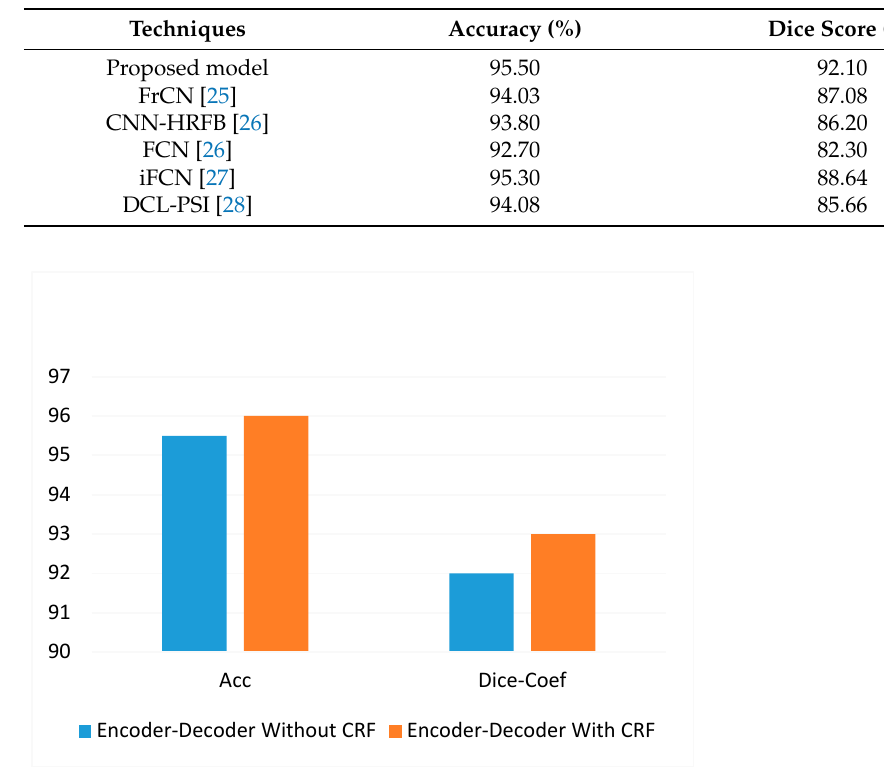
Table 3. Classification experiment results of each model.